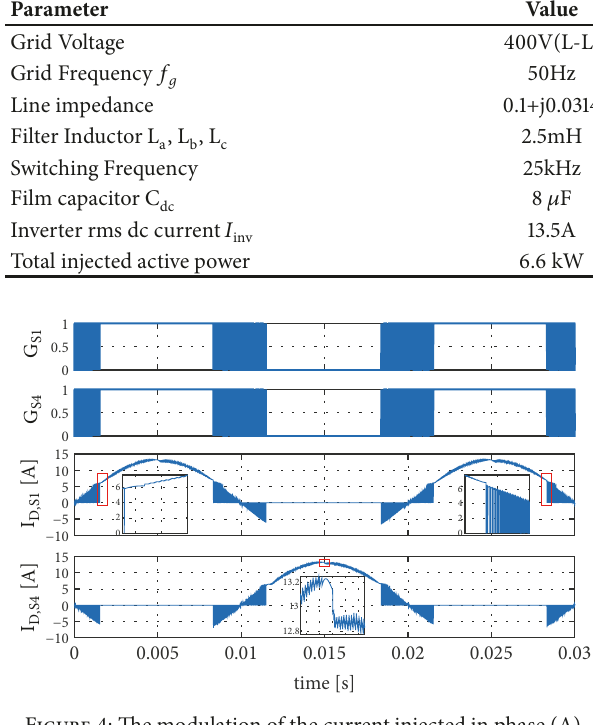
Figure 4: The modulation of the current injected in phase (A).